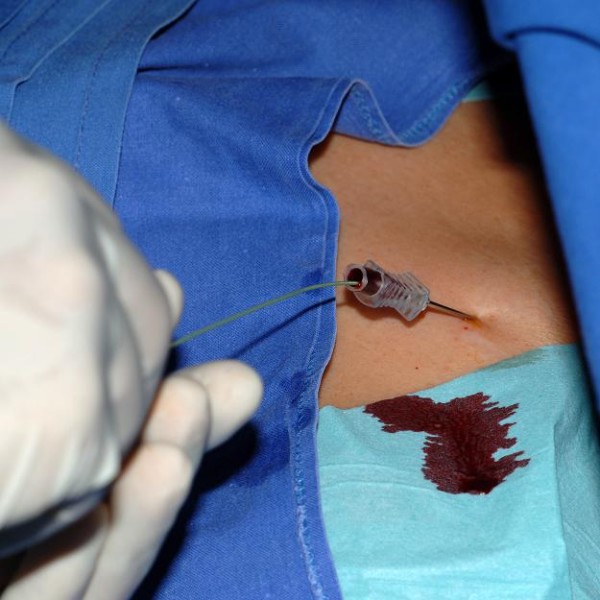
Puncture of V. Subclavia – introducing guiding wire (Seldinger technique).